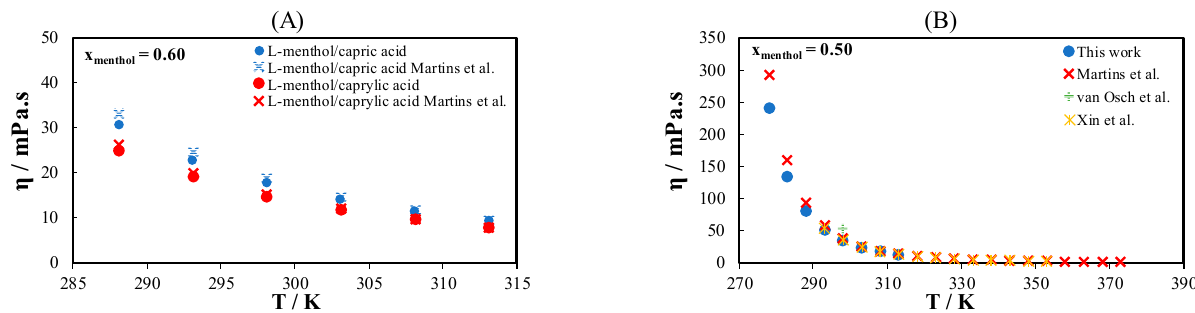
Figure 3. ( A ) Viscosity of L -menthol/caprylic acids and L -menthol/capric acid and ( B ) viscosity of L -menthol/thymol measured in this study compared with the data in the literature. Filled symbols are data measured in this work, and cross symbols are data in the literature from Martins et al. [16,32], van Osch et al. [5], and Xin et al. [33].